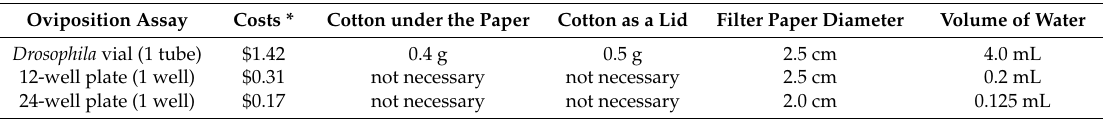
Table 1. Costs per mosquito tested, amount of cotton, filter paper diameter, and volume of water required in different methods for oviposition assays.